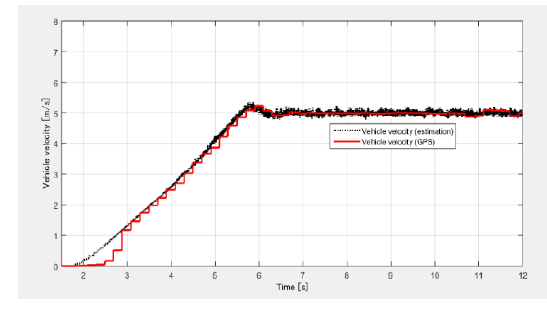
( a ) Global motion: vehicle velocity